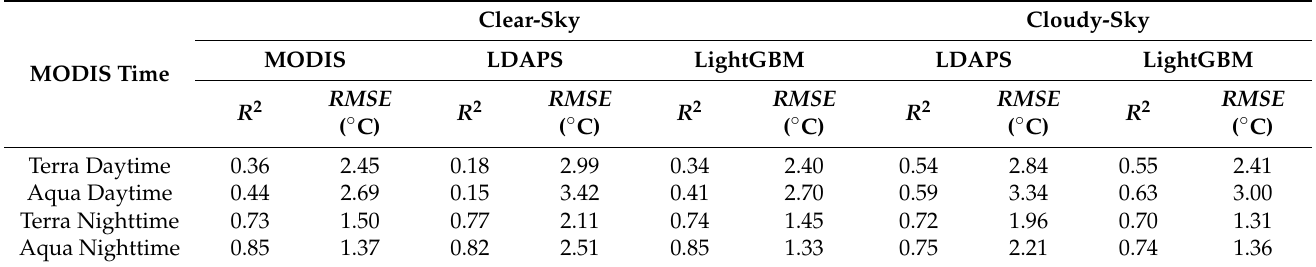
Table 2. LOSOCV results for LSTs from MODIS, LDAPS, and the proposed LightGBM models under clear and cloudy-sky conditions against the bias-corrected in situ LST measurements at 22 ASOSs